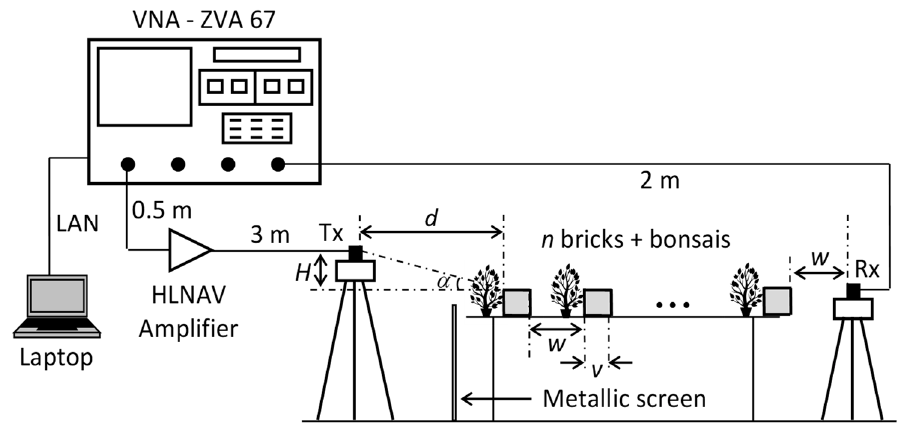
Figure 2. Scheme of the measurement